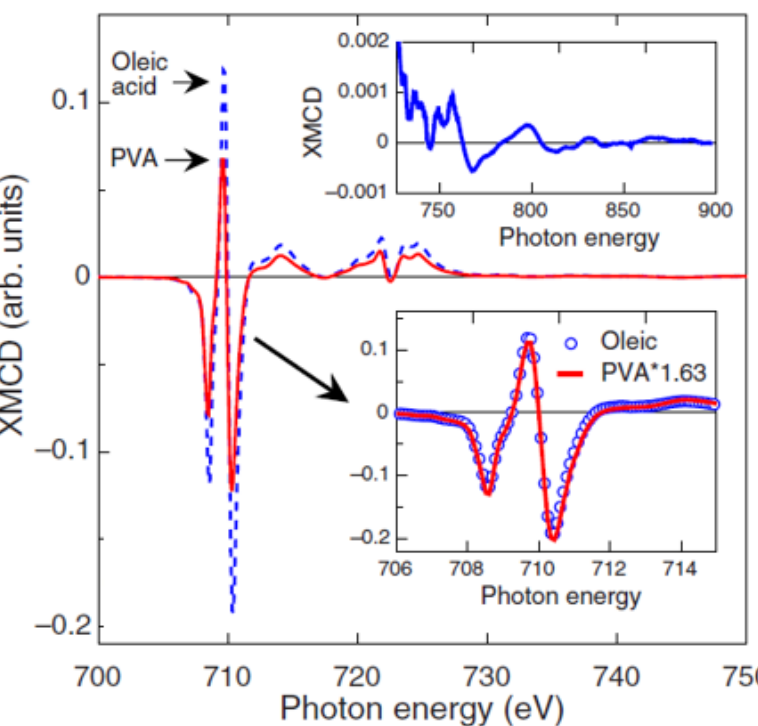
Figure 2. XMCD curves at the L 2,3 Fe edges recorded on the oleic acid (dashed blue line) and PVA (solid red line) samples. Upper inset: detail of the high-energy XMCD curve of the oleic acid sample. Bottom inset: detail of the scaling of the XMCD curves at the Fe L 3 edge measured on both samples. The Figure is reprinted with permission from Ṕ rez et al. [30].